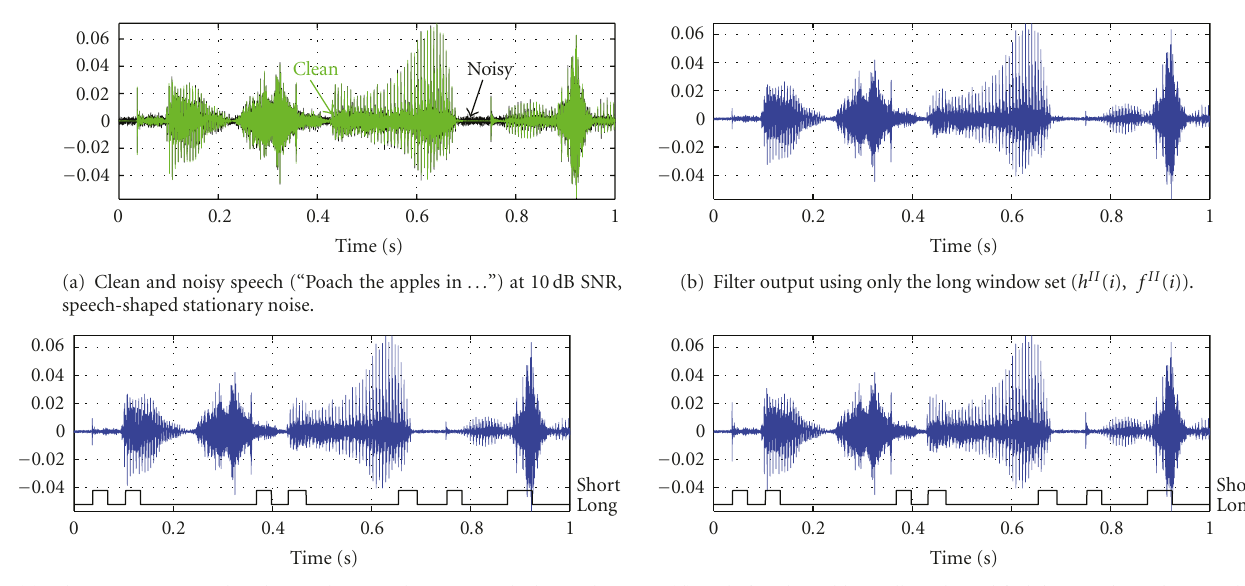
(d) As before, but additionally with modified decision-directed approach. Figure 18: Time-domain signals of input and the results obtained after noise reduction with Wiener filter and the methods proposed in Sections 4.1 and 4.2.